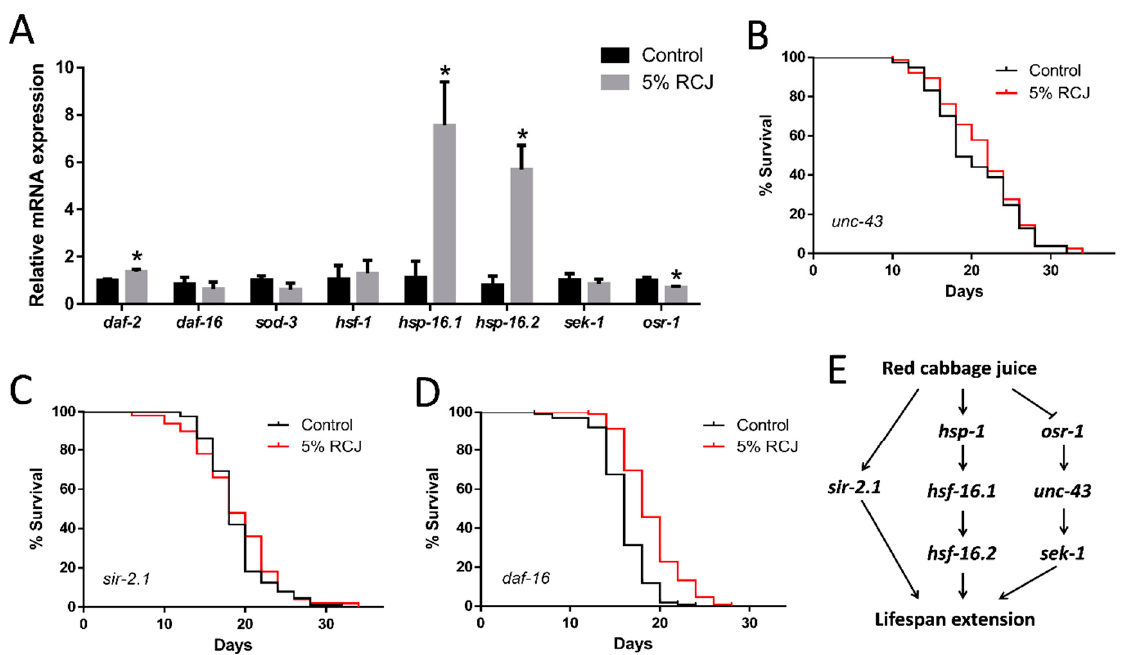
Figure 7. The molecular mechanism of red cabbage juice (RCJ) in lifespan extension. ( A ) Relative mRNA level of daf-2 , daf-16 , sod-3 , hsf-1 , hsp-16.1 , hsp-16.2 , sek-1 , osr-1 after 2 days of 5% RCJ treatment. Data are presented as mean ± SD. * p < 0.05 vs. control by one-way ANOVA followed by Bonferroni correction. ( B ) Survival curves of daf-16(mgDf50) . ( C ) Survival curves of sir-2.1(ok434) . ( D ) Survival curves of unc-43(n498n1186) . ( E ) Hypothetical model of action of the longevity extension mediated by RCJ.